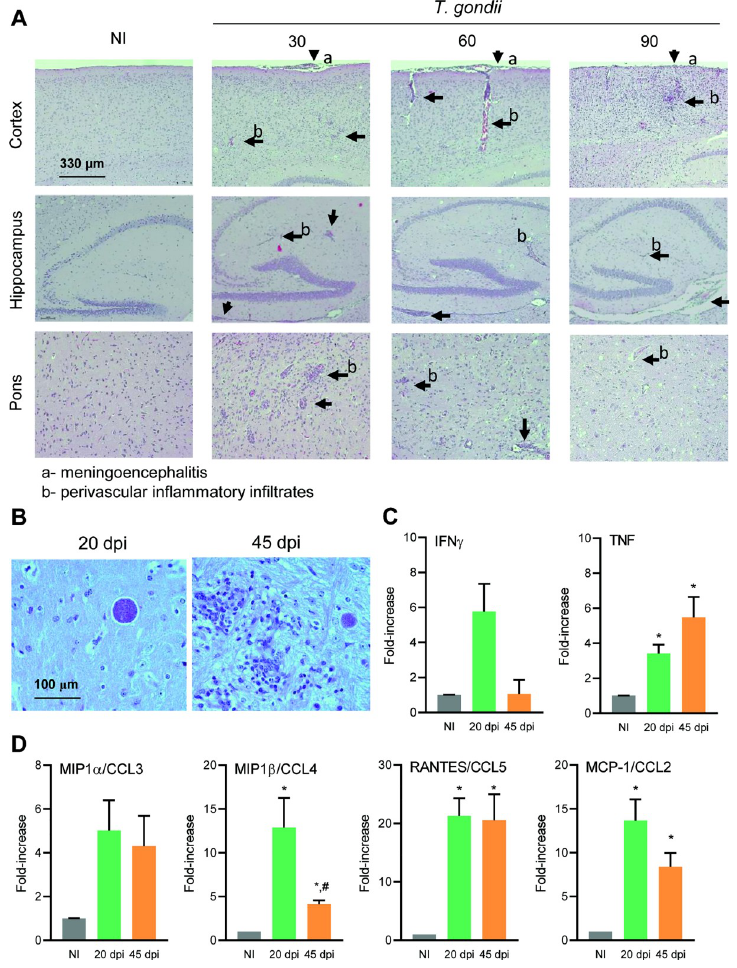
Fig 8. Toxoplasma gondii -infected C57BL/6 mice showed generalized neuroinflammation in early and long-term chronic phase of infection. ( A ) Infected mice presented inflammatory foci with meningoencephalitis and perivascular inflammatory cuffs in all evaluated areas of the CNS in early (30 dpi) and long-term (60 and 90 dpi) chronic infection. Bar = 330 μ m. ( B ) Cysts devoid of inflammation were firstly detected in the CNS at the acute phase (20 dpi, left panel), and the inflammation is already settled in the chronic phase (45 dpi, right panel). Bar = 100 μ m. ( C ) Increased expression of the pro-inflammatory cytokines IFN γ and TNF was detected in the acute phase, and TNF expression was sustained at the chronic phase of infection. ( D ) In the acute phase, the expression of MIP1 α /CCL3, MIP1 β /CCL4, RANTES/CCL5 and MCP-1/CCL2, was increased. The upregulation of the expression of TNF and CC-chemokines were sustained at 45 dpi. Each experimental group consisted of 2–4 NI mice and 2–10 T . gondii -infected mice, in two independent experiments. Data are expressed as means ± SEM, and were analyzed using ordinary one-way ANOVA. � , p < 0,05 comparing T . gondii- infected and NI mice, and #, p < 0.05 comparing acute and chronic groups of T . gondii infected